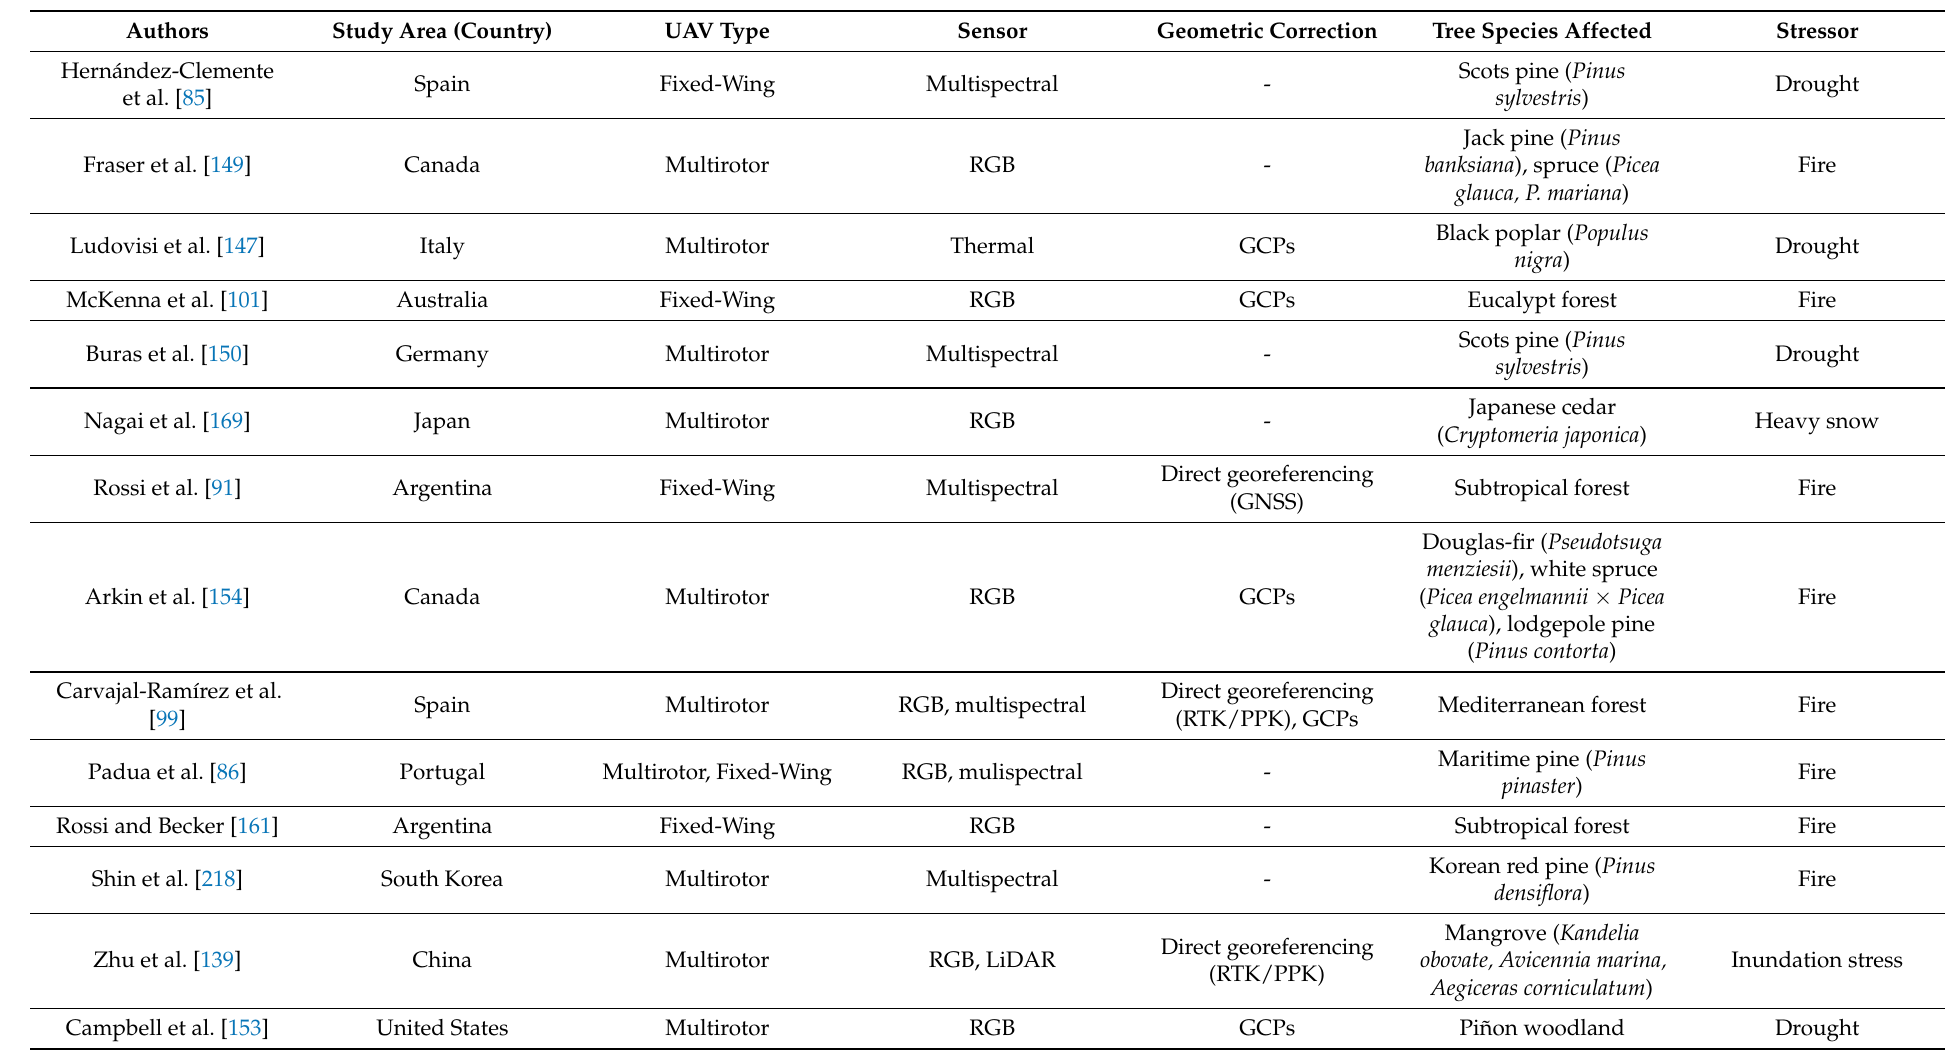
Table A4. Abiotic stressors: reviewed articles regarding abiotic agents of tree